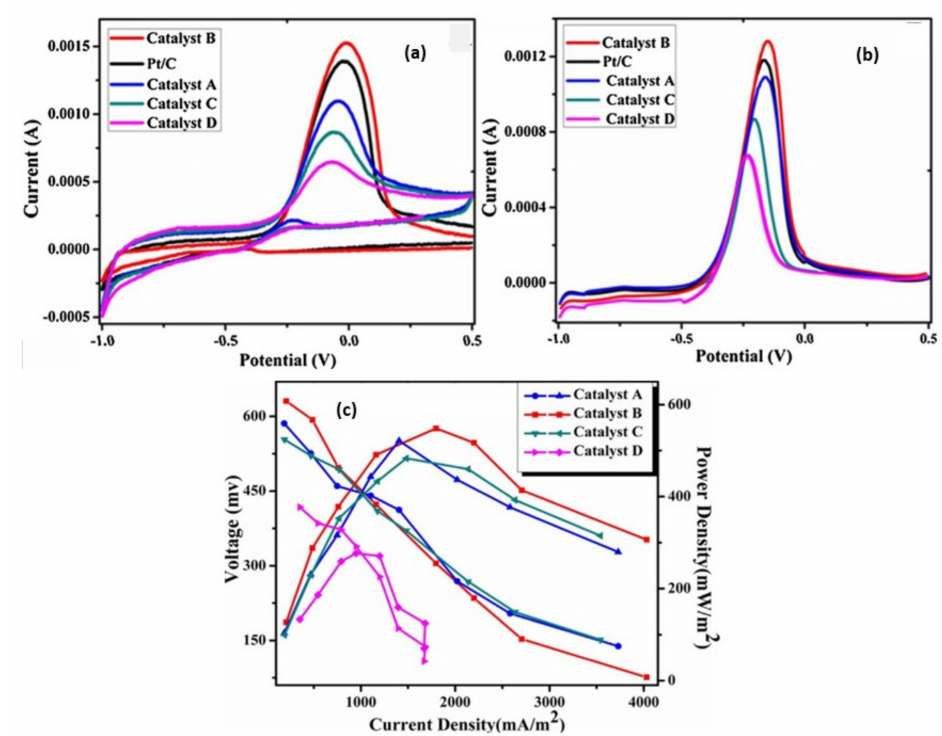
Figure 8. ( a ) Cyclic voltammograms; ( b ) LSV of Co/Al 2 O 3 –rGO at different wt% concentrations in a mixed bacterial culture, scan rate 10 mv/s; ( c ) polarization curve and power density curve of cathode catalysts at different Co wt%. (Reprinted with permission from [1]. Copyright 2017, Elsevier).